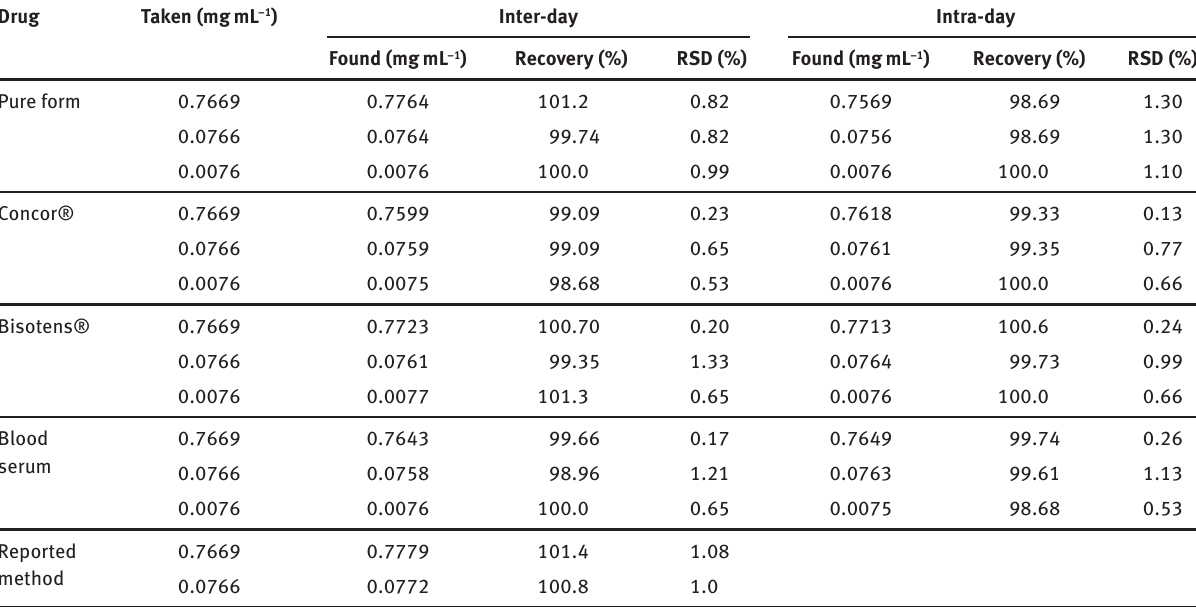
Table 4: Assessment of pure form Concor® tablets, Bisotens® tablets, and blood serum intra- and inter-day consistency and accuracy of the proposed process